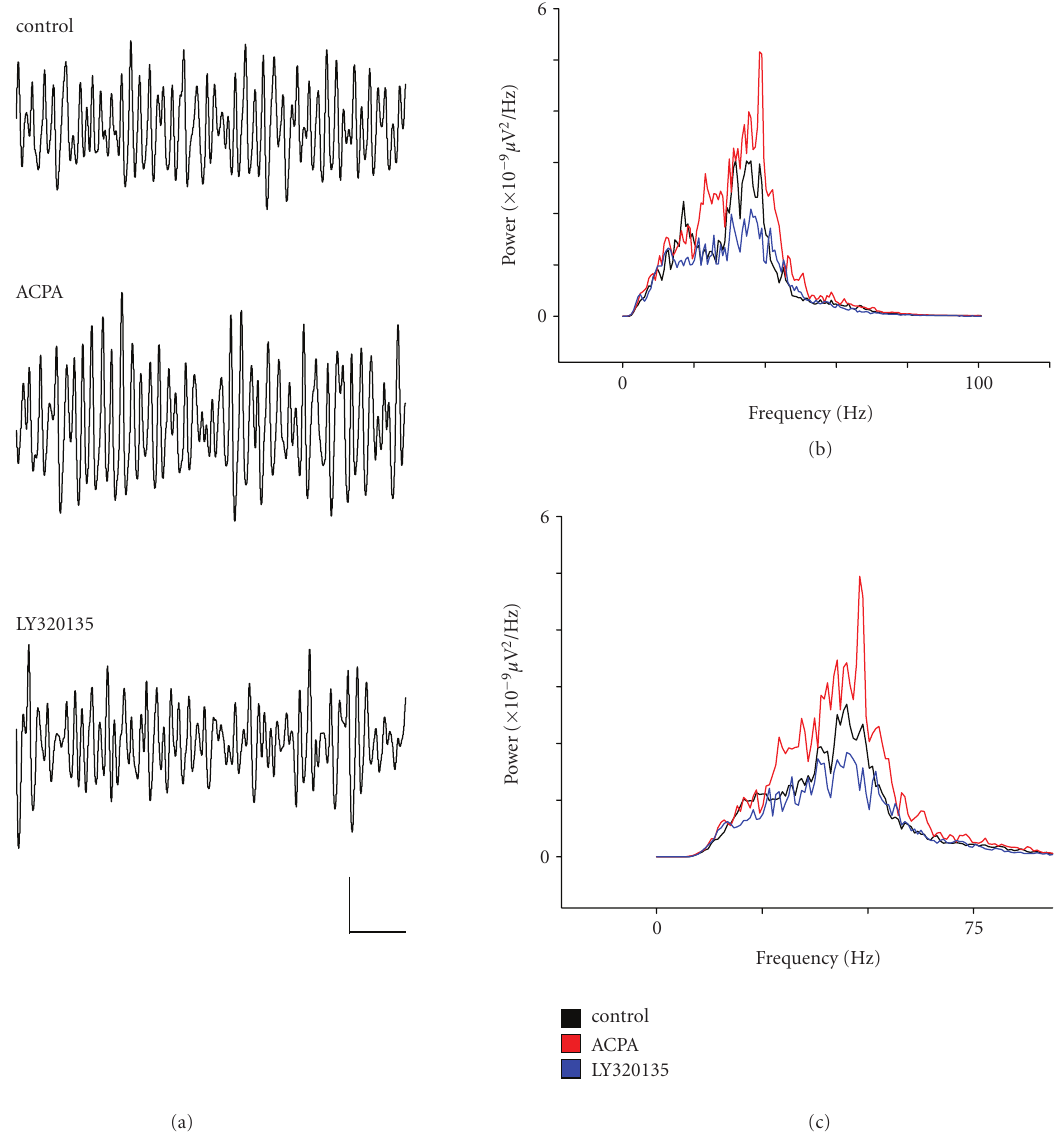
Figure 1: The e ff ects of ACPA and LY320135 on γ -band activity in mEC layer II. (a) Example traces from layer II showing γ -oscillations under conditions in which ACPA (10 μ M) or LY320135 (500nM) were applied. (b) Plot of power spectral density during drug application (filtered between 2–100 Hz). Control (black line), ACPA (red line), LY320135 (blue line). (c) Similar plot to (b) bandpass filtered between 30–90 Hz. Scale bar = 200 milliseconds × 100 μ